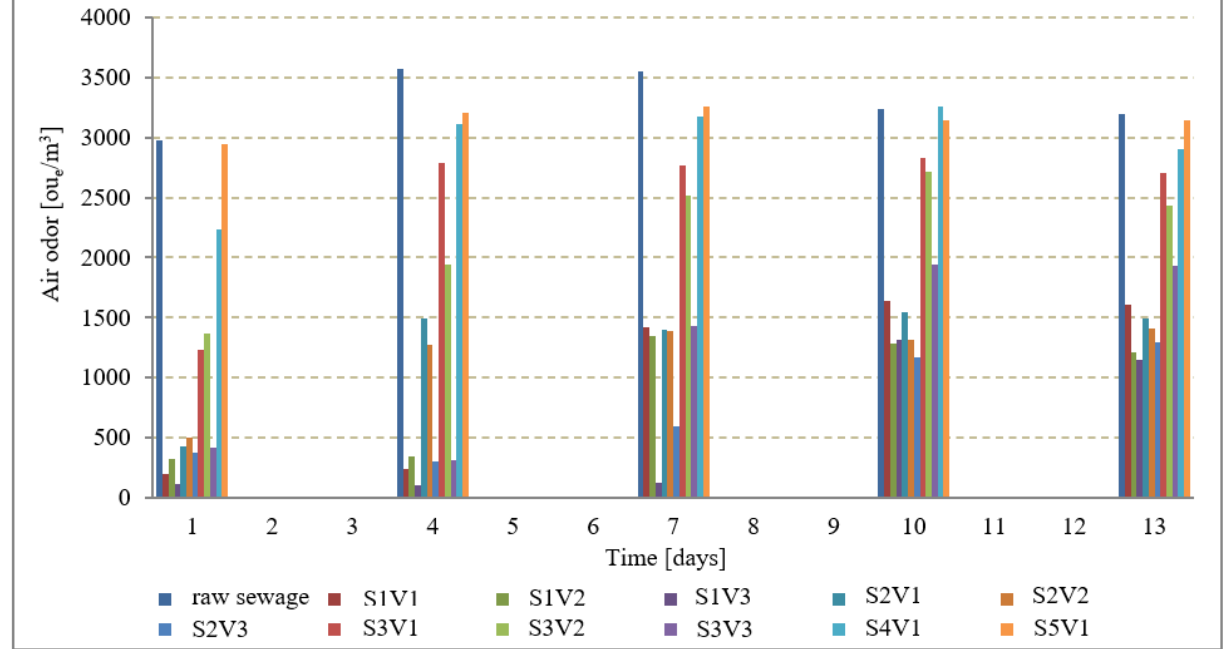
Figure 6. Odor levels in the air across variants.